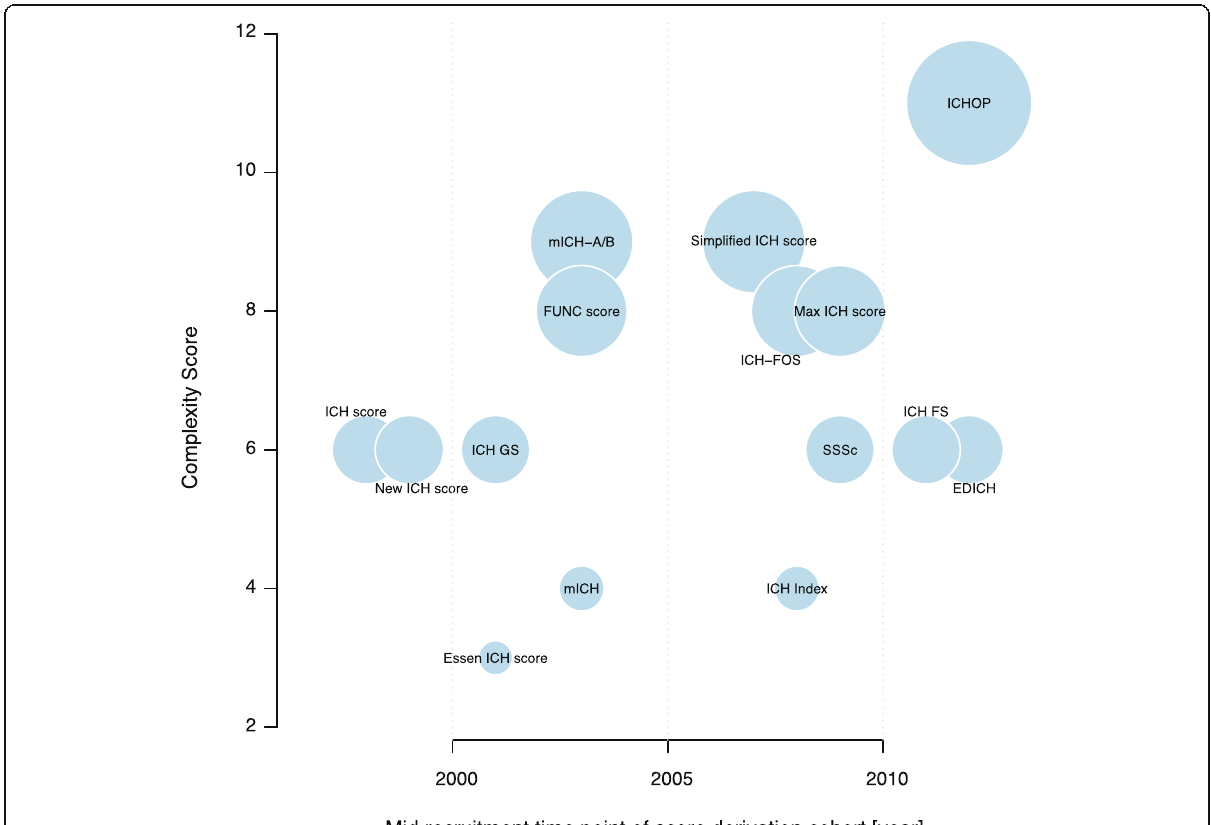
Fig. 1 Ease of clinical use of ICH prediction scores. Size of bubbles encodes the degree of complexity of the respective scoring system depending on number and availability of individual score components (see Methods